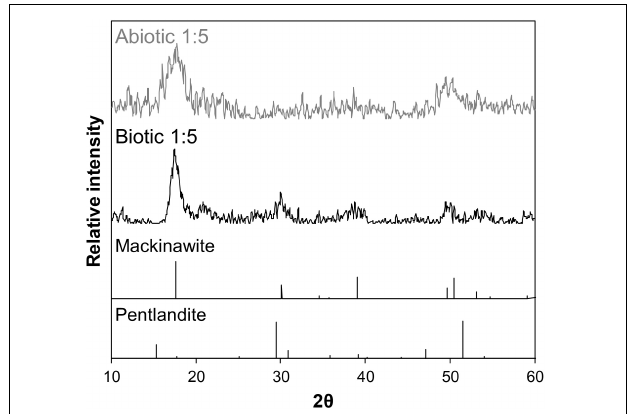
FIGURE 7 | Background-subtracted XRD patterns of biogenic (black) and abiogenic (gray) precipitates at [Ni] aq /[Fe] aq = 1:5 shown at the upper portion of the figure, with corresponding standard patterns of mackinawite and pentlandite (from American Mineralogist database; Downs and Hall-Wallace, 2003) shown at the bottom portion. The sample patterns are most consistent with mackinawite.